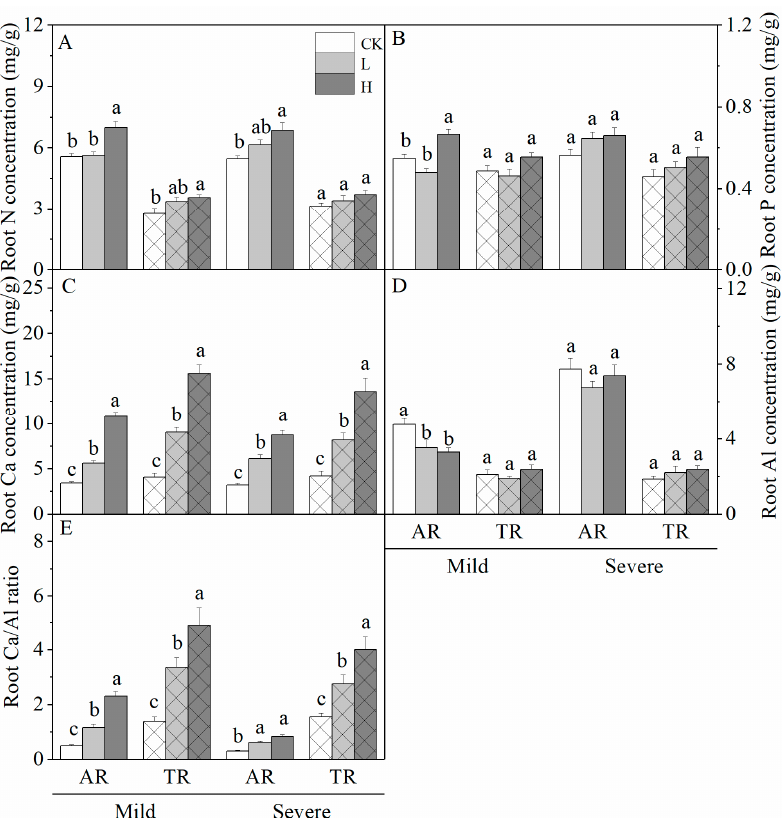
Figure 2. Fine root nutrient concentrations of two functional roots among three treatments (C, control; L, low CaCO 3 addition; H, high CaCO 3 addition) and two acidification degree soils (Mild, mildly acidified soil; Severe, severely acidified soil). Data shown are mean + SE (N = 8). Bars without grid represent Absorptive fine roots (AR), and bars with grid represent transportation fine roots (TR). Different lower-case letters indicate significant differences at p < 0.05 level among different liming treatments in the same functional root (AR or TR) within the same soil (Mild or Severe), as evaluated by one-way ANOVA; ( A ) root N concentration; ( B ) root P concentration; ( C ) root Ca concentration; ( D ) Root Al concentration; ( E ) Ca/Al ratio in the root system.